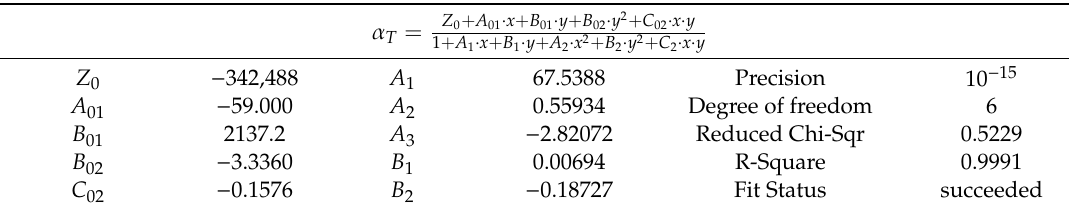
Table 3. The universal equation for predicting the shift factor.